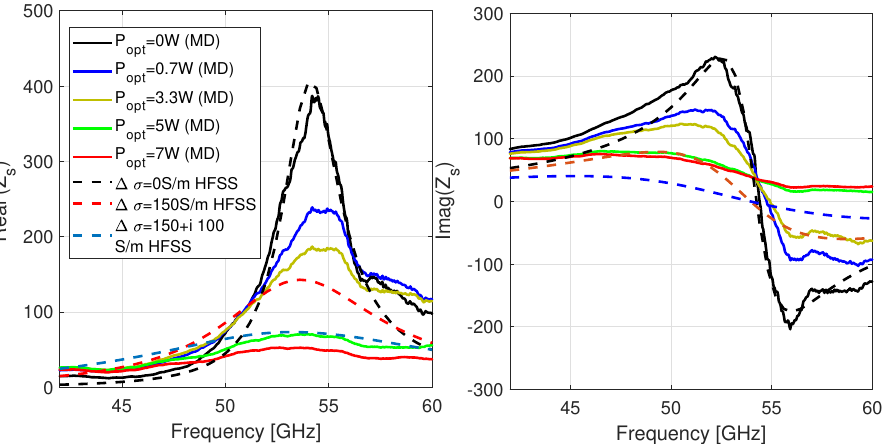
Figure 9. Measured data (MD) and Simulated with HFSS (left) Real ( Z s ) and (right) Image ( Z s ) under different optical illumination ( ∆ σ ∗ ) of MTS printed on HR Silicon substrate of thickness 250 µ